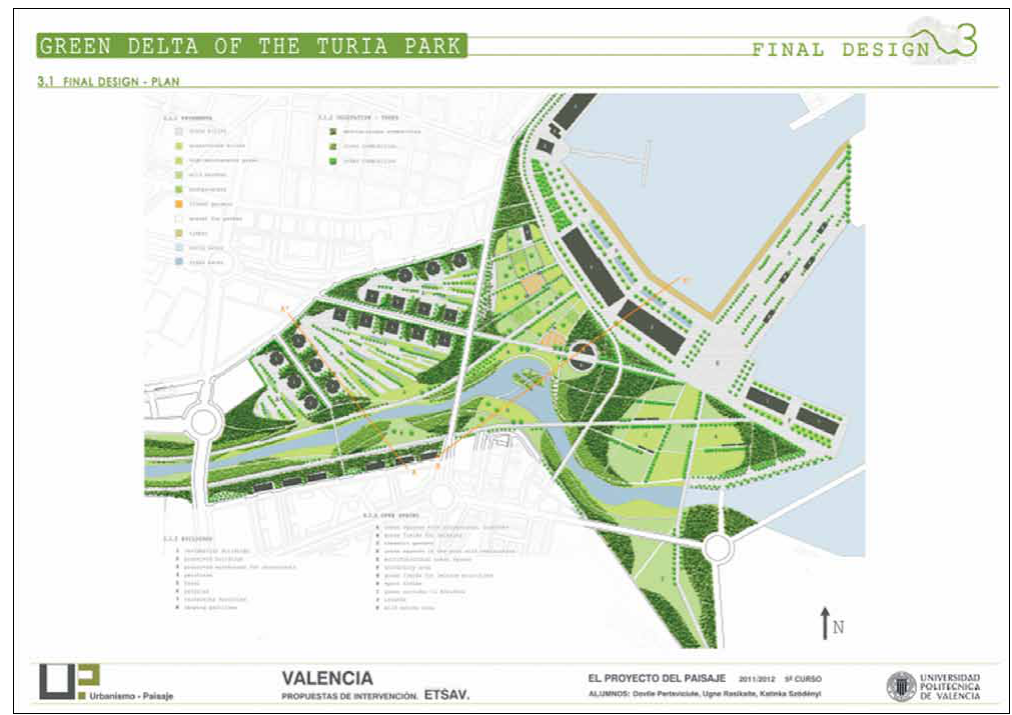
fig. 9. Proposal for re-arangement of park in Valencia werer prepared by KTu students while participating in the exchange